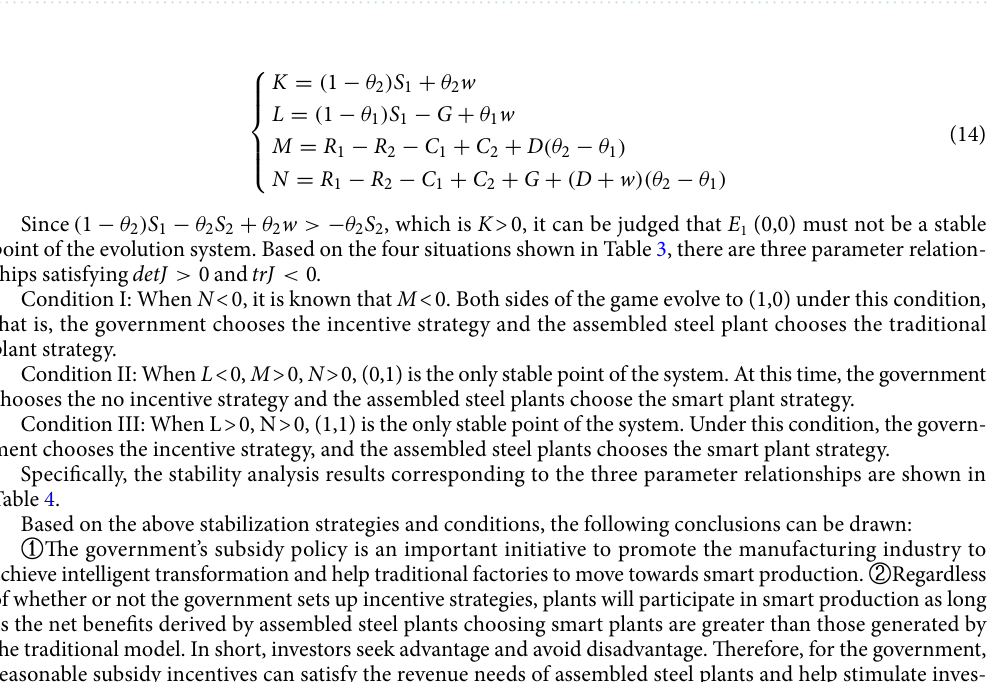
Table 3. Stability analysis of the equilibrium points.